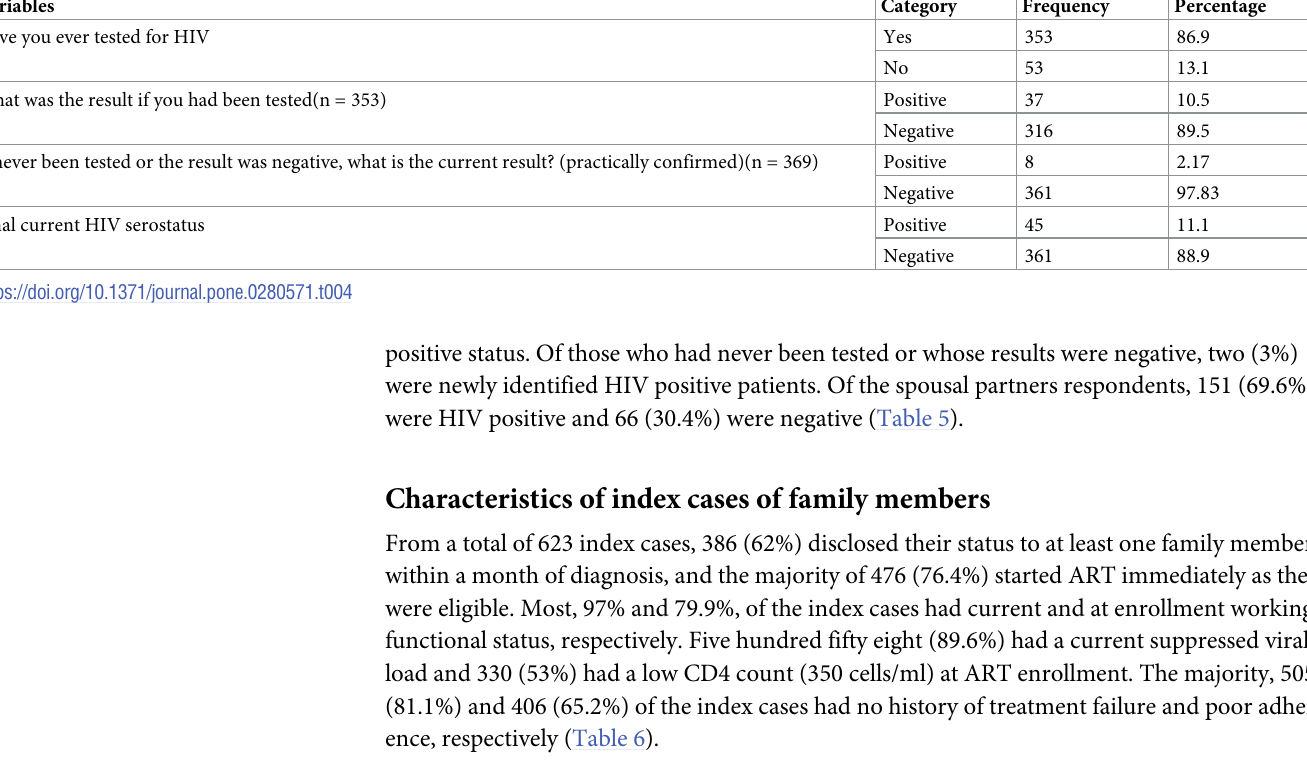
Table 4. HIV serostatus and testing history of biological children of index cases, Sodo Town, Southern Ethiopia, 2021 (N = 406). Variables